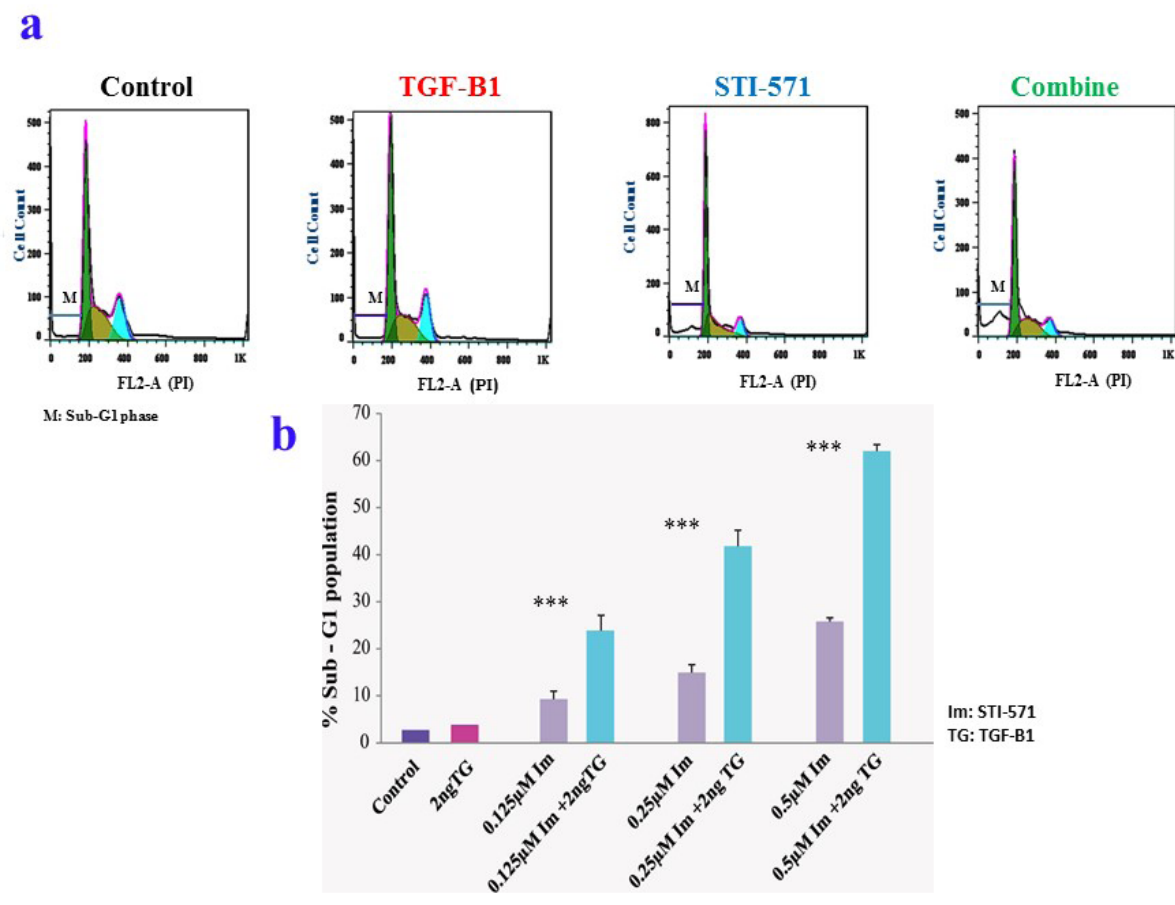
Figure 2: a) Cell cycle histogram for K562 cells treated with 2 ng/mL TGF-β1 and 0.5 µM STI-571, individually or in combination, for 48 h. The area M indicates the sub-G1 phase, and the highest sub-G1 cell cycle arrest was demonstrated by the combination therapy. b) Cell cycle graphs for K562 cells treated with 2 ng/mL of TGF-β1 and different concentrations of STI-571, individually or in combination, for 48 h. The percentage of cells in the sub-G1 phase gradually increased with increasing STI-571 concentrations and with the combination therapy. The data are represented as the mean ± SD. *** indicates that P <